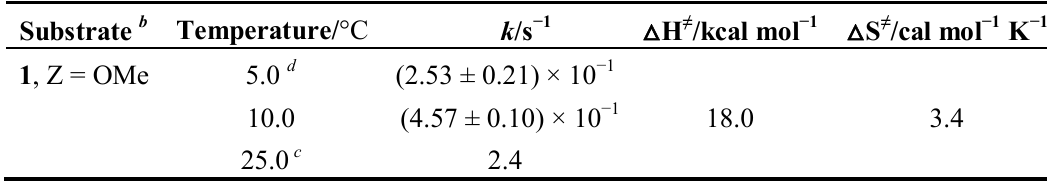
Table 2. Rate constants ( k /s − 1 ) and activation parameters for solvolyses of p -methoxy benzoyl chloride ( 1 , Z = OMe) in formic acid a .